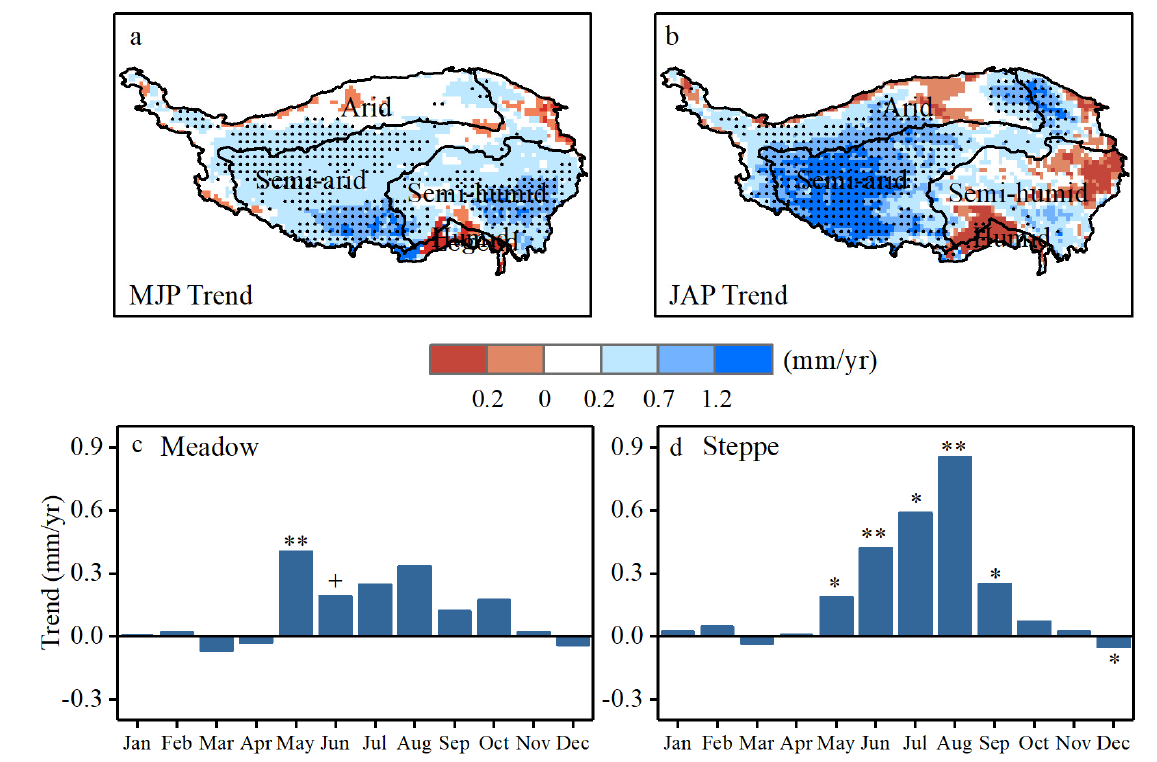
Figure 2. Spatial patterns of precipitation in MayJune (MJP) ( a ) and July–August (JAP) ( b ) change trend and monthly precipitation trend overall the meadow ( c ) and the steppe ( d ) on the TP during the past four decades (1979–2019). The black dots in ( a , b ) suggest that the trends are statistically significant (Mann–Kendall test, p < 0.05). Labels +, * and ** in ( c , d ) indicate the Mann–Kendall test significance levels of 0.1, 0.05 and 0.01, respectively.